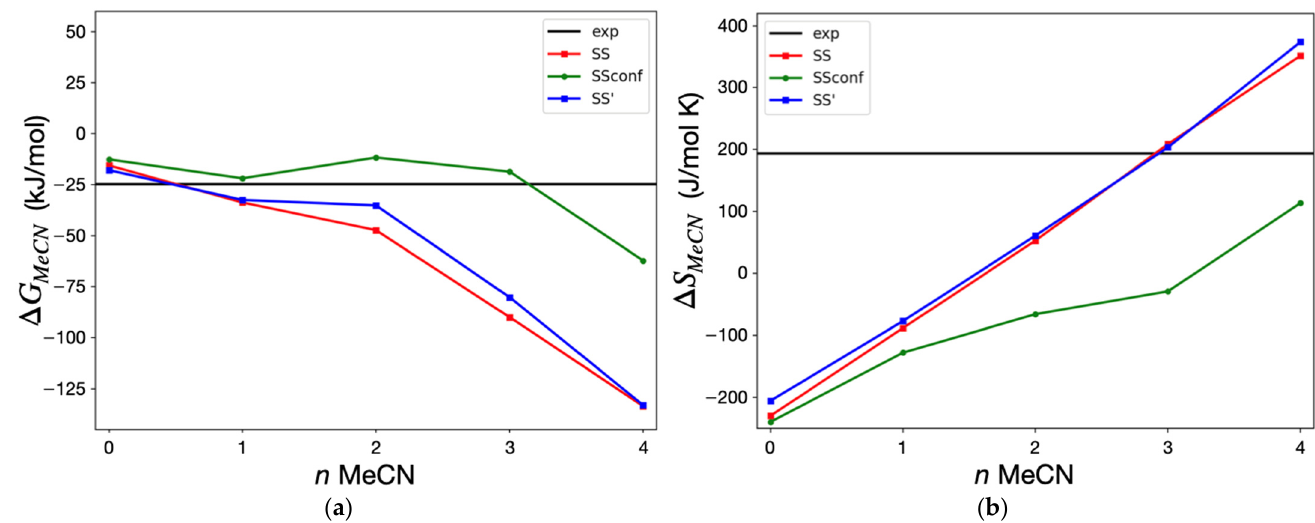
Figure 9. Variation in ( a ) Gibbs energy and ( b ) entropy for the binding F − to 4a with n molecules ( n = 0–4) of MeCN explicitly considered. The reactions considered to generate the plot are summarised by, e.g., SS : nMeCN + F − (cid:10) nMeCN + SS : F −